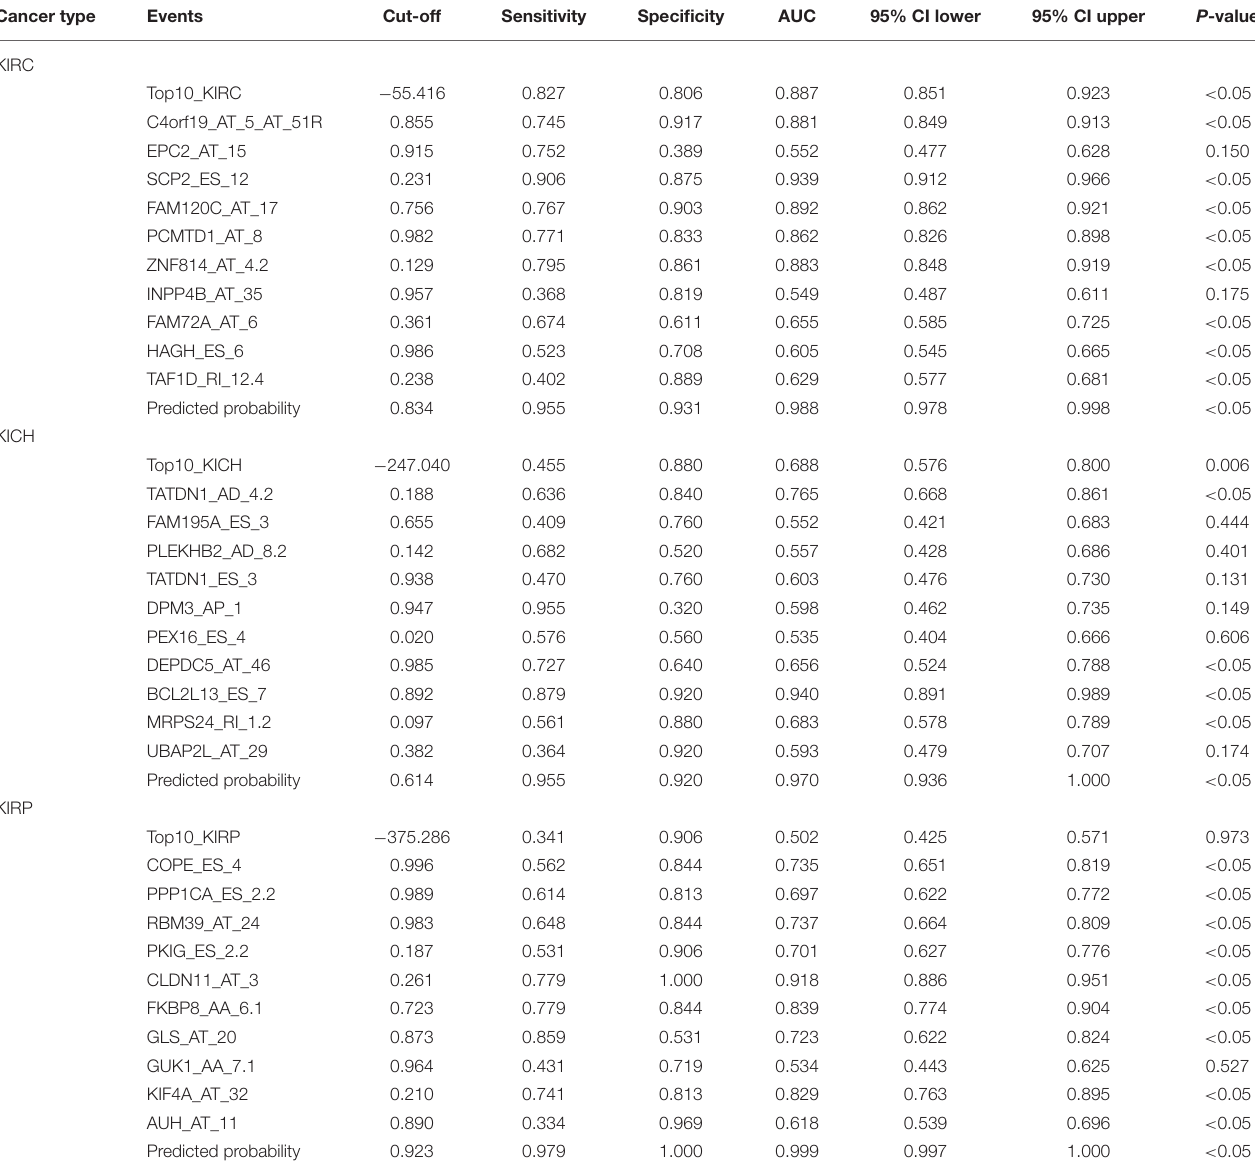
TABLE 5 | ROC curve results of survival related factors in predicting diagnostic test. Cancer